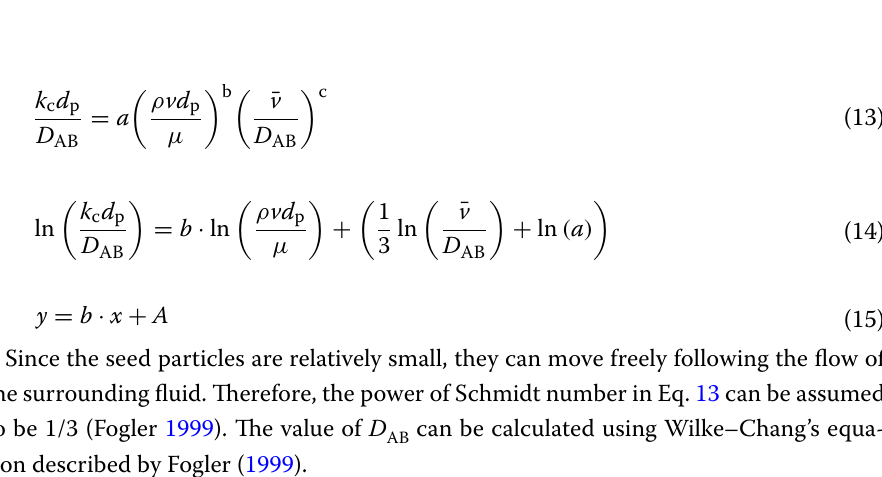
at various pH and temperature values